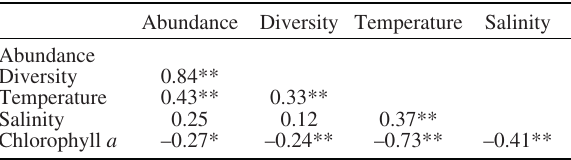
Table 1. – Matrix showing the Spearman correlation coefficients for decapod larvae variables (abundance, nº larvae/100 m 3 ; diversity, Shannon diversity index values) and environmental variables (tem- perature, °C; salinity; chlorophyll a , mg Chl- a m –3 ) at the surface (2 m depth); * p<0.05; ** p